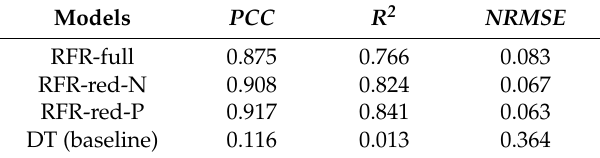
Table 6. Performance of the RFR and baseline models as applied to predict water price for